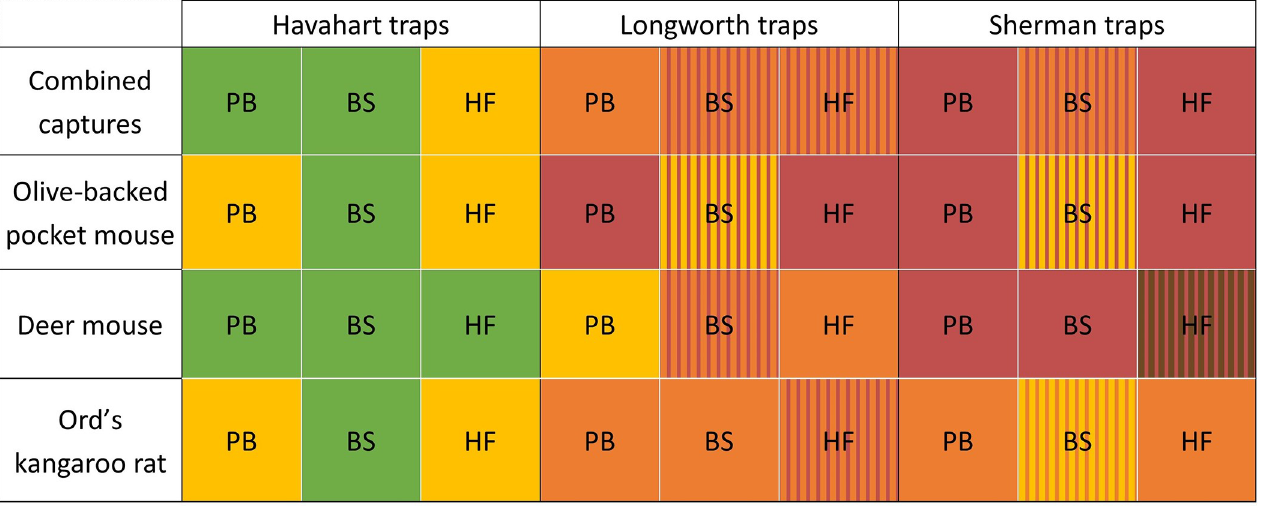
Fig 3. Bait and trap selection by species including Longworth traps. Colors represent differences in selection within a species, where trap-bait combinations with the same color are not significantly different from each other. When colors are different, green = strongly positive selection, yellow = weak positive selection, orange = weak avoidance and red = strong avoidance. Bi-color hatching indicates no significant differences from solid colors of the same type. BS = bird seed bait, HF = 3-way horse feed bait, PB = peanut butter bait.